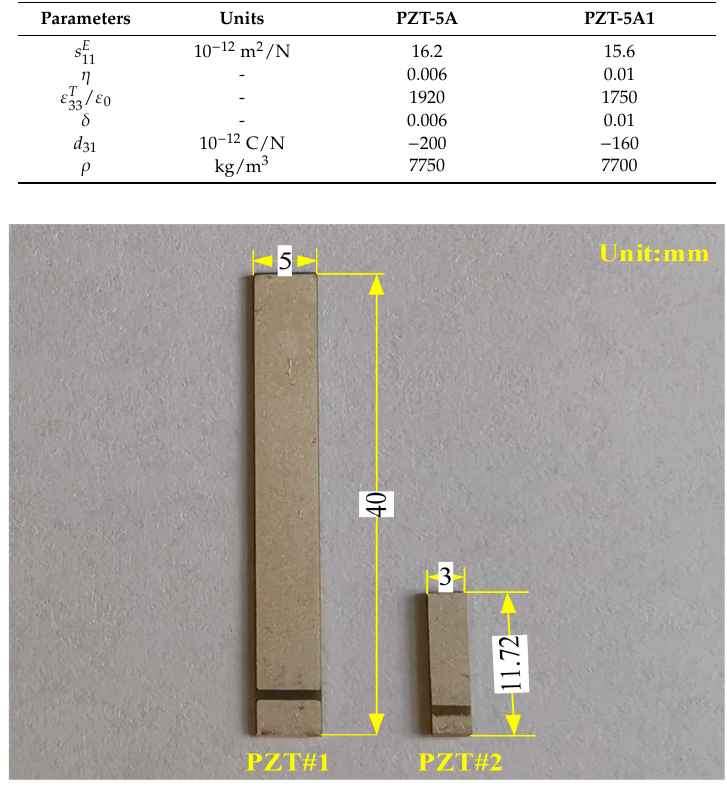
Figure 3. Comparative schematic of PZT#1 and #2.